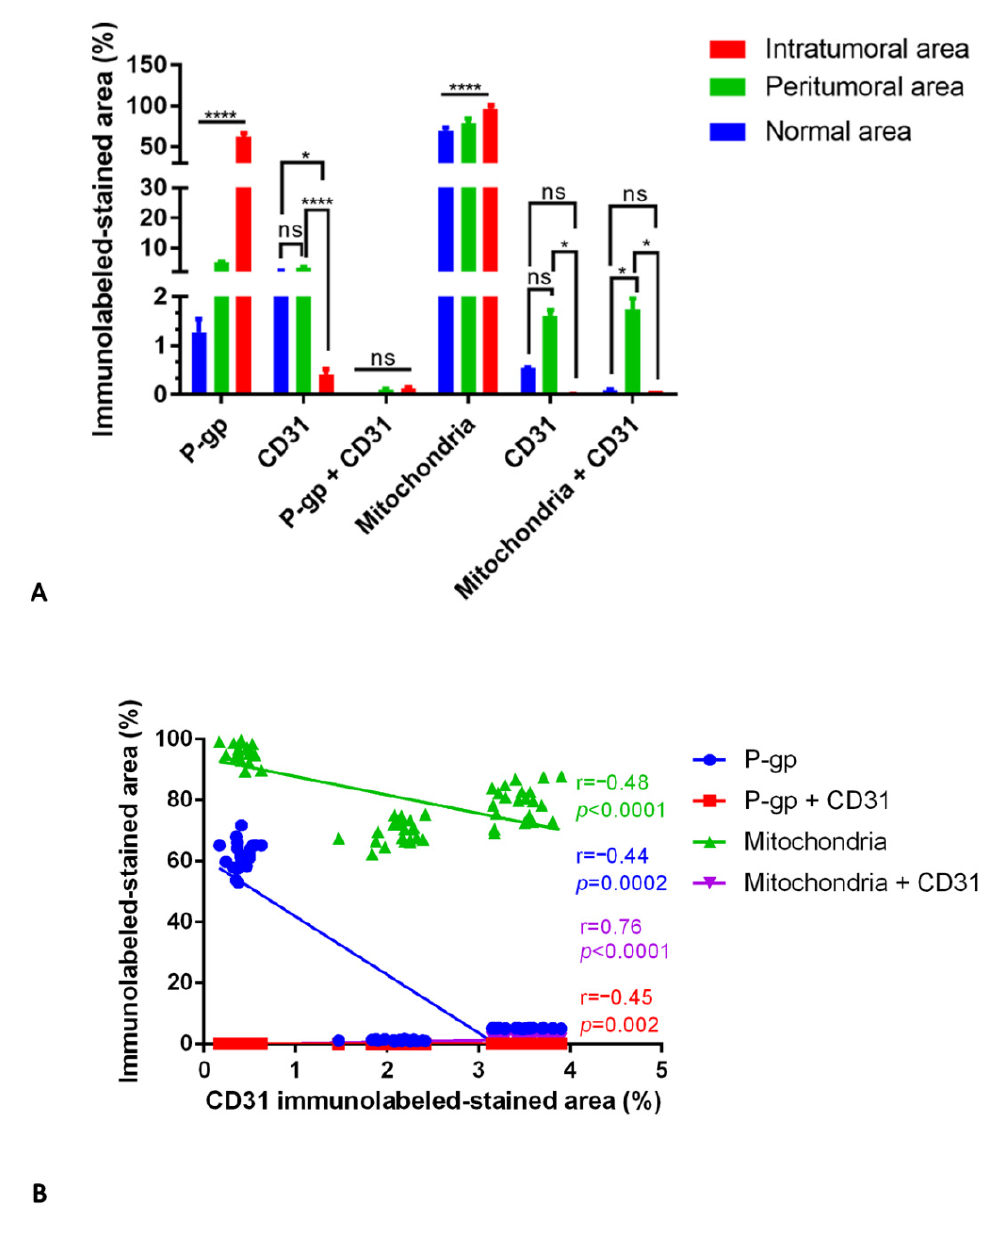
Figure 4. P-gp/CD31 and mitochondria/CD31 quantification in meningioma. P-gp, mitochondria and CD31 were evaluated by immunohistochemistry and were estimated as a percentage of digital quantification within the same spatial ROIs on meningioma serial sections using the colocalization algorithm. P-gp and mitochondria expression progressively increase from normal to intratumoral areas ( A ). CD31 expression is reduced in the intratumoral areas compared with peritumoral and normal ones ( A ). No significant differences are noted in the P-gp + CD31 ( A ) colocalized expression in all three areas. Significant is the mitochondria + CD31 ( A ) colocalized expression in the peritumoral area compared to the others. Linear regression analysis ( B ) shows a positive and very strong statistical correlation between the CD31 expression and the mitochondria + CD31 co-expression. The CD31 correlation with P-gp, P-gp + CD31, or mitochondria is fair [For P-gp: Y = − 19.1 * X + 60.99; for P-gp + CD31: Y = − 0.01274*X + 0.1094; for mitochondria: Y = − 6.037*X + 93.85; for mitochondria + CD31: Y = 0.5011*X − 0.3575]. Data are reported as mean ± SD, and the Tukey’s post hoc test was used to compare all groups after two-way ANOVA. N = 22. ns, not significative; * p < 0.05; **** p < 0.0001.